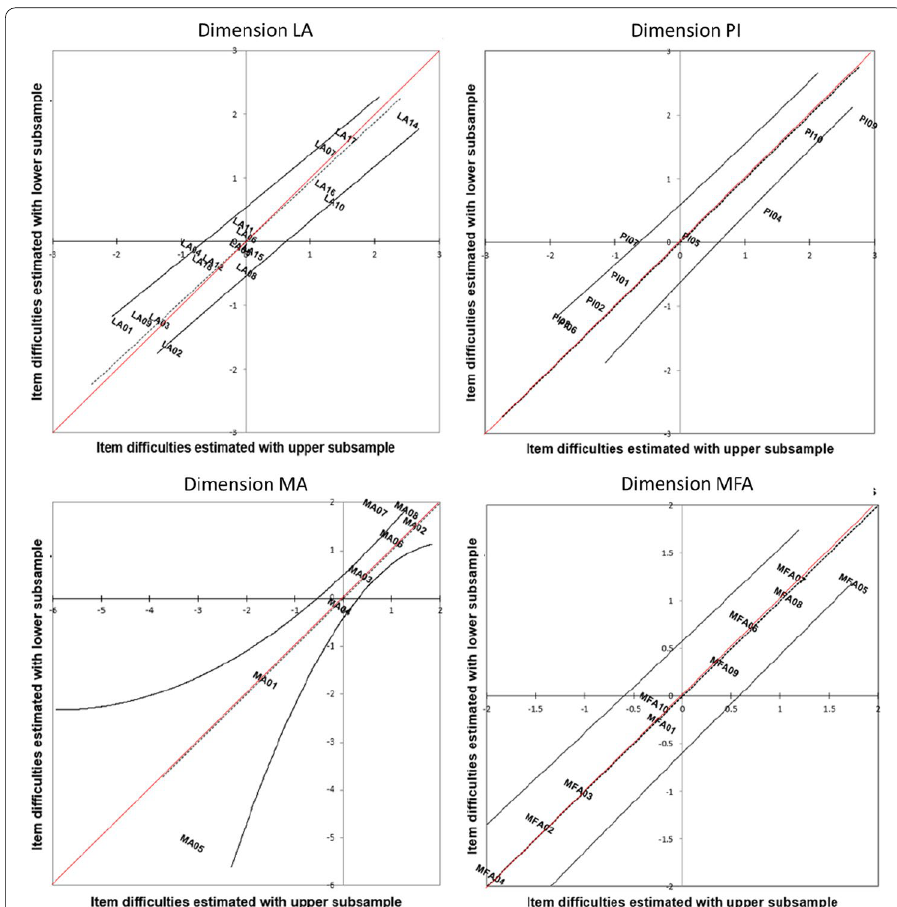
Fig. 4 Item difficulties: 95% confidence interval around identity line, estimated from the lower and upper part of the sample selected for the final